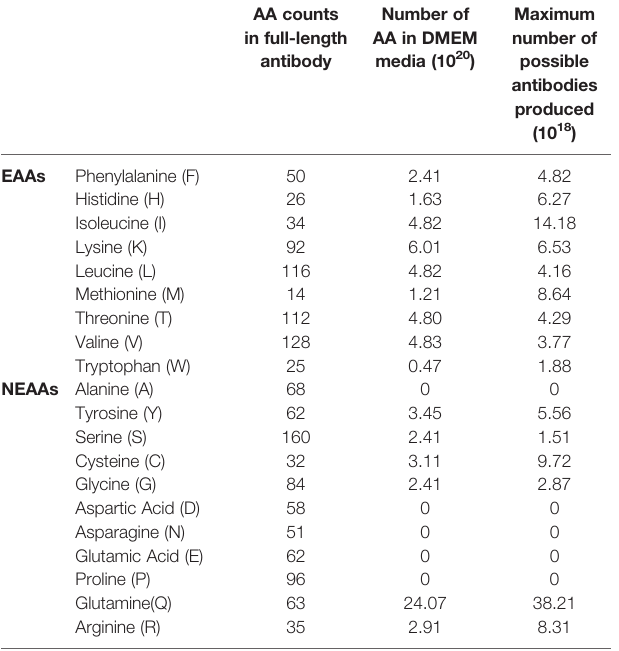
The number of amino acids in DMEM media were calculated based on the weight (g/L) of amino acid component used in the formula. Maximum number of antibodies produced refers to the theoretical maximum number of full-length antibodies that could be synthesized based on number of amino acids in DMEM media and to the amino acid counts in the representative average of amino acids.